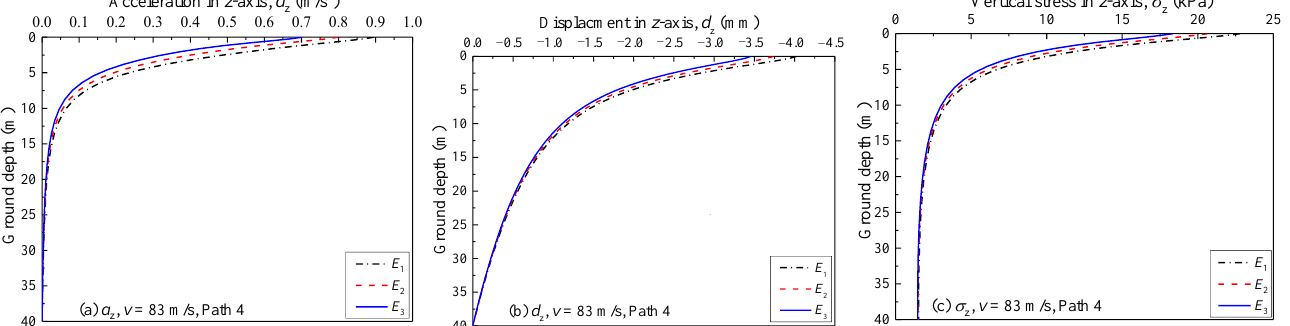
Figure 17. Variations of a z , d z , and σ z with depth under different embankment stiffnesses in Path 4: ( a ) a z ; ( b ) d z ; ( c ) σ z.